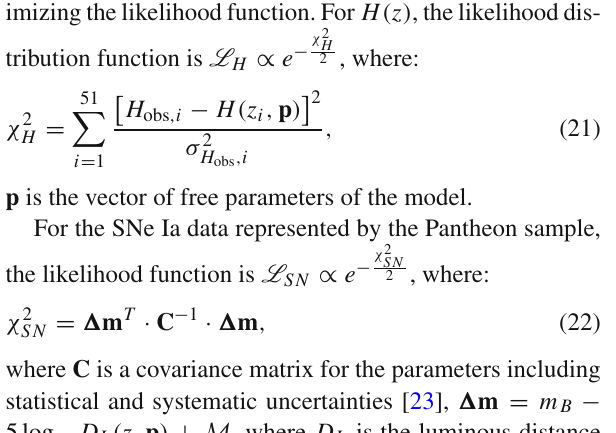
Table 1 Mean values and 95% CL for the parameters H 0 , (cid:7) m , α and (cid:7) dm for Case